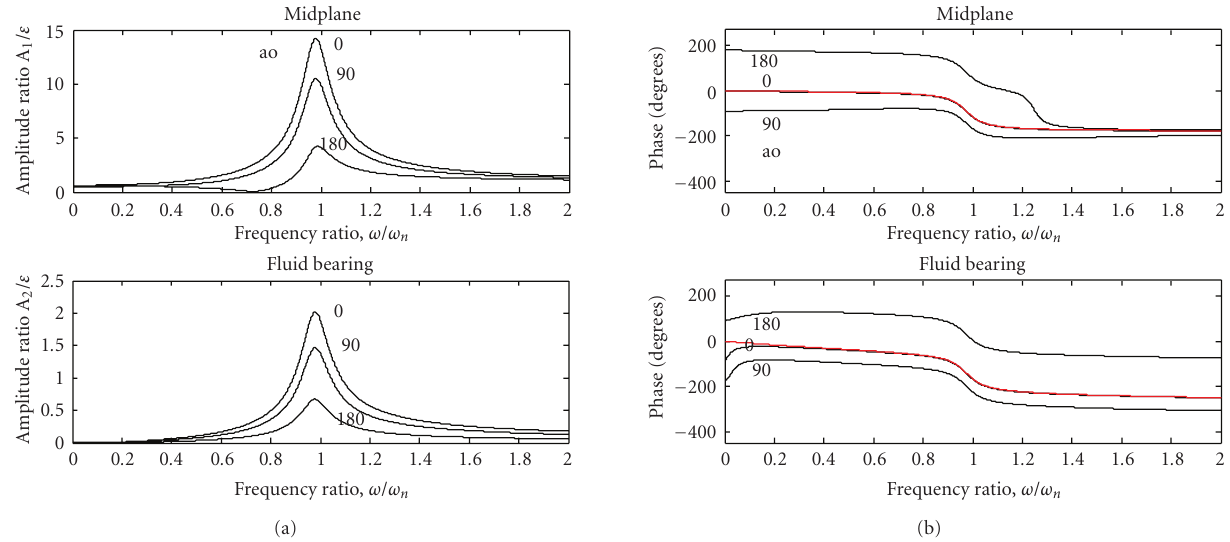
Figure 9: Amplitude (a) and phase response (b) for various bow orientations relative to the imbalance plane. Ro = 0.5. The curve in red is for a rotor with imbalance but no bow.